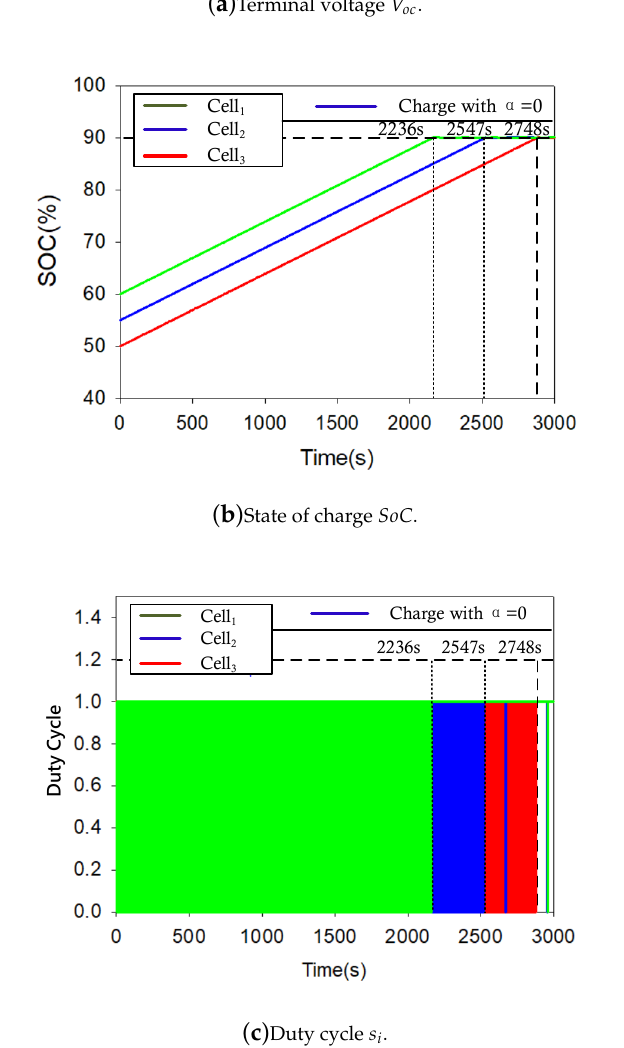
Figure 9. Results without artificial potential field (conventional) control